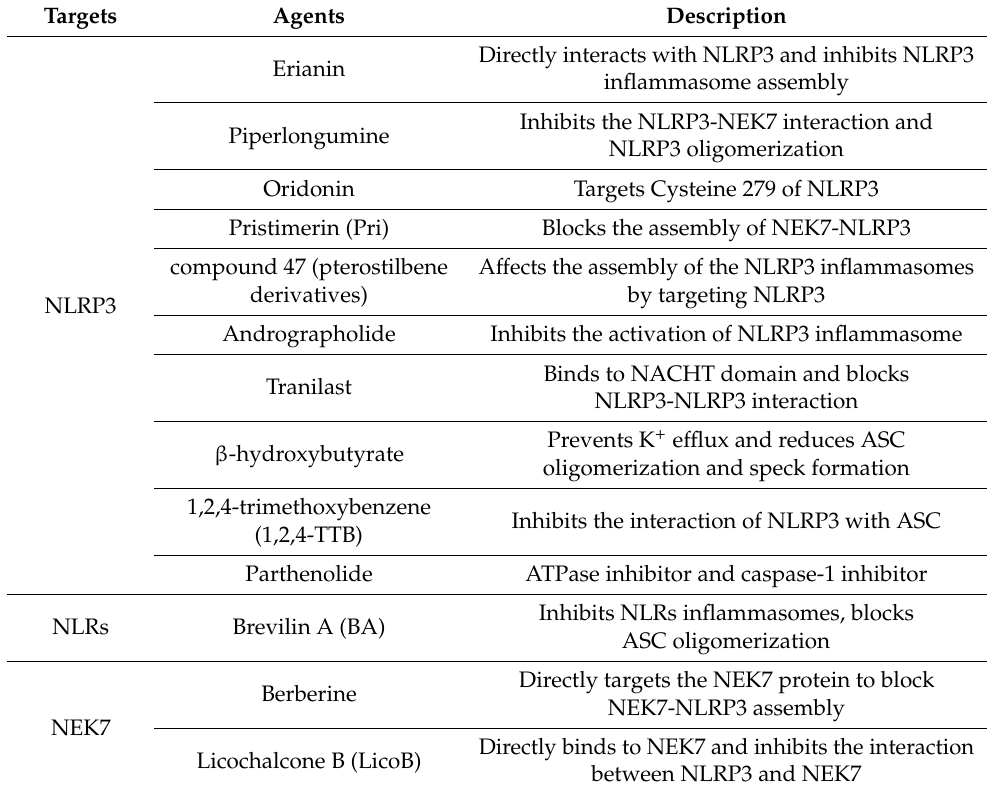
Table 2. Natural inhibitors targeting NLRP3 inflammasome